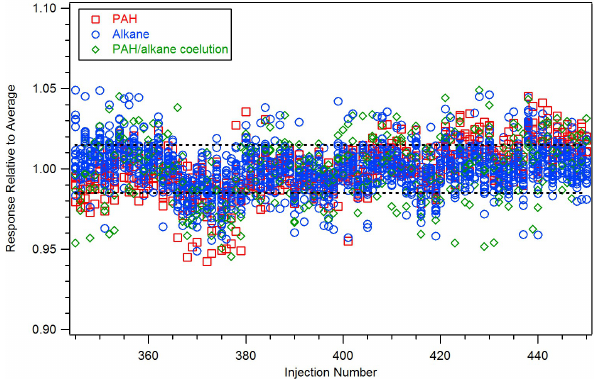
Fig. 2. Stability of the AutoInject over 106 runs. FID detector re- sponse of a given compound is shown relative to the average re- sponse of that compound over all runs shown. Symbols differen- tiate PAHs, alkanes, and co-eluting peaks that contain both PAHs and alkanes while the dashed line represents the standard deviation of relative response for all standard compounds measured (1.5%).